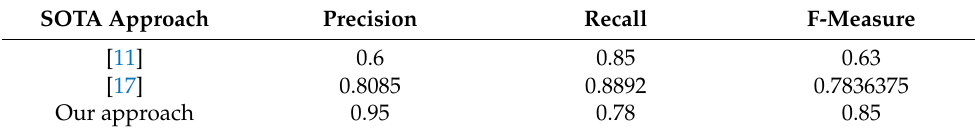
Table 5. Comparison